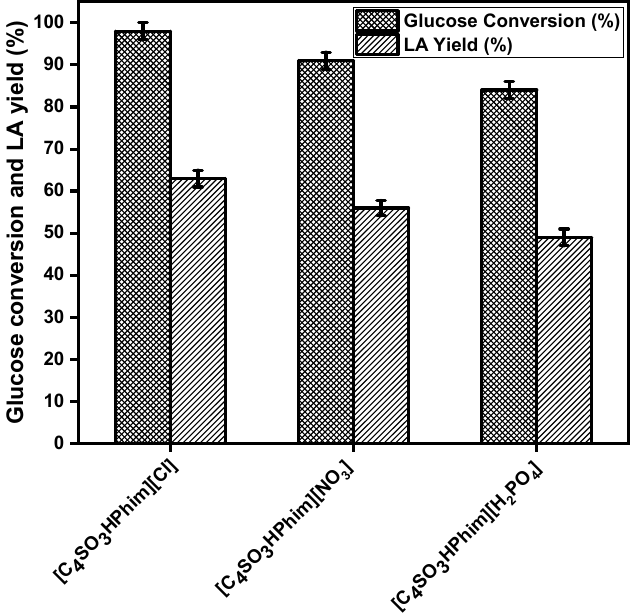
Figure 3. Effect of the Brønsted acidic ionic liquids on the conversion of glucose to LA. Reaction conditions: ionic liquid = 500 mg, 100 mg glucose, 2.0 mL water, temp = 180 °C, t = 3 h.